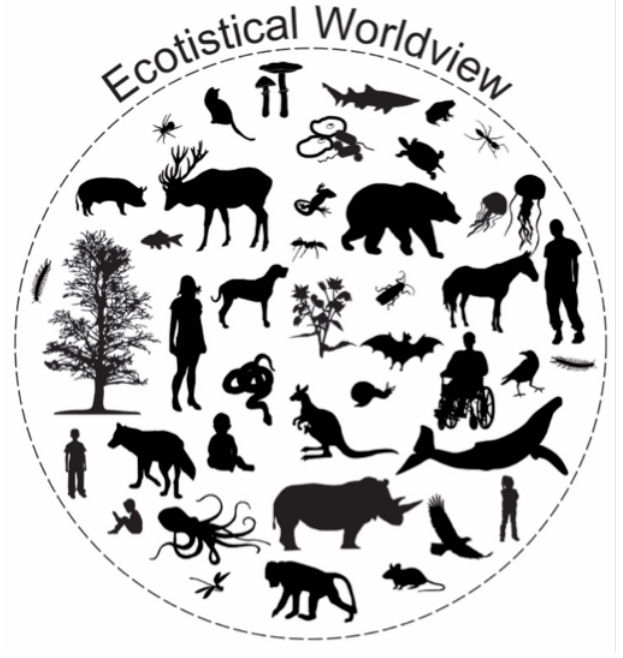
Figure 2. Ecotistical Worldview adapted from “Differing Worldviews” (Martusewicz et al., 2015, p. 11). This figure illustrates an ecologically balanced worldview often overlooked and devalued in Western industrial